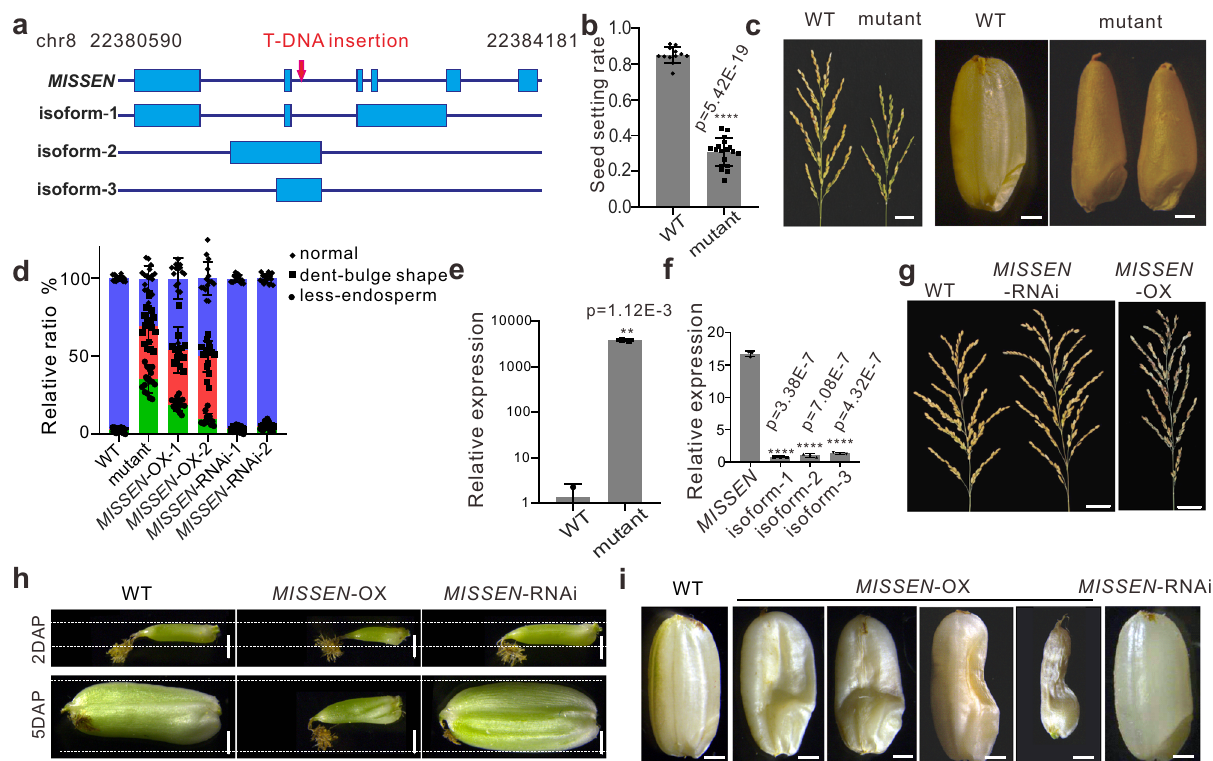
Fig. 1 Phenotype analysis of MISSEN mutant plants. a The gene structure of the lncRNA MISSEN and its three isoforms. The T-DNA insertion site of the mutant is indicated by the red arrow. b The seed setting rate of the T-DNA insertion mutant. c The panicles and seeds of WT and mutant plants. Scale bars, 3 cm for panicles and 1 mm for seeds. d The ratio of abnormal seeds in WT, mutant, MISSEN -OX-1, MISSEN -OX-2, MISSEN -RNAi-1, and MISSEN -RNAi-2 plants. Values are the means ± SD ( n = 19, 18, 15, 15, 16, 15 plants). e The relative expression level of the isoforms of MISSEN . Values are the means ± SD ( n = 3 replicates, normalized against ACTIN2 ); f The relative expression of MISSEN in the WT and the mutant. Values are the means ± SD ( n = 3 replicates, normalized against ACTIN2 ); g The panicles of WT, MISSEN -RNAi, and MISSEN -OX plants. Scale bars, 3 cm; h The developing seeds of the WT and the different transgenic plants at day 2 and day 5 after pollination. Dotted white lines highlight the width of MISSEN -RNAi caryopsis. Scale bars, 1 mm; i The mature seeds of WT, MISSEN -RNAi, and MISSEN -OX plants. Scale bars, 1 mm. Signi fi cant differences were identi fi ed at the 5% (*), 1% (**), 0.1% (***) and <0.01% (****) probability levels using two-tailed paired t